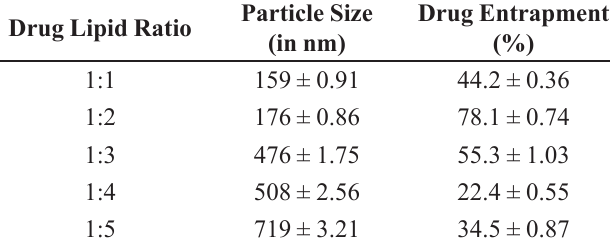
TABLE I - Comparison between different methods used for the preparation of SLNs